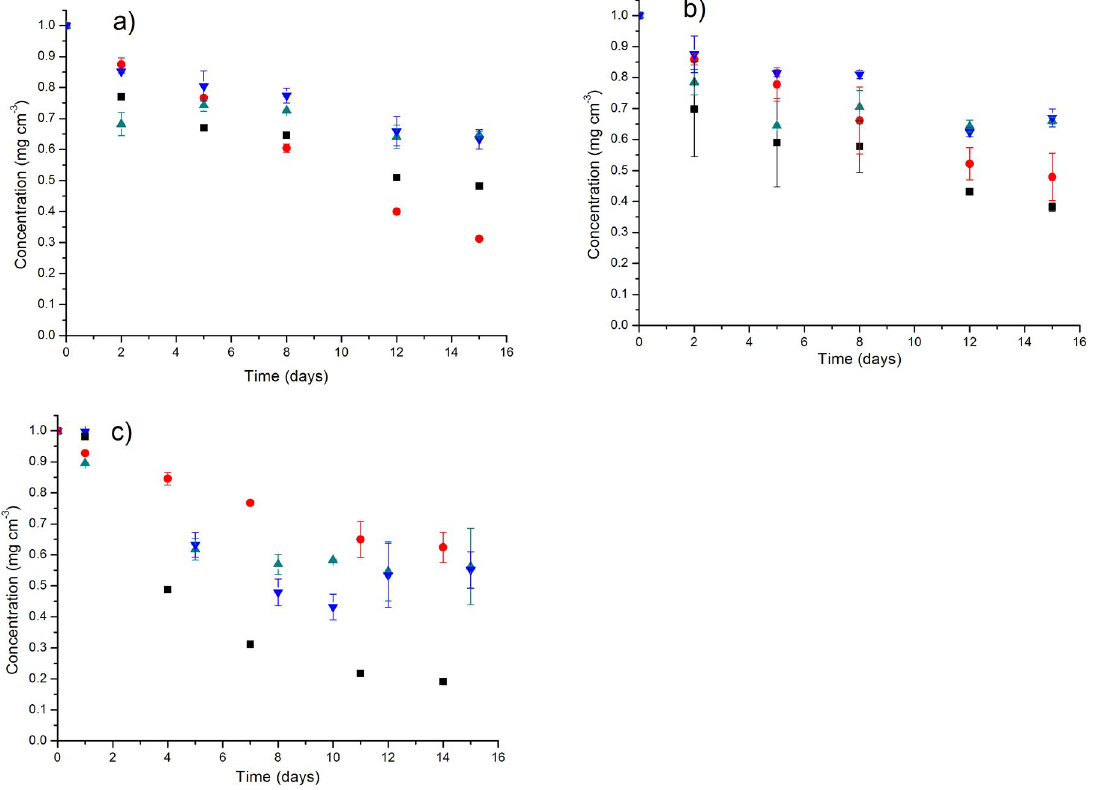
(■); VC (●); NP (▲) and NP (▼) wt ox ex AA saturation at 25 ºC in absence of light. 2